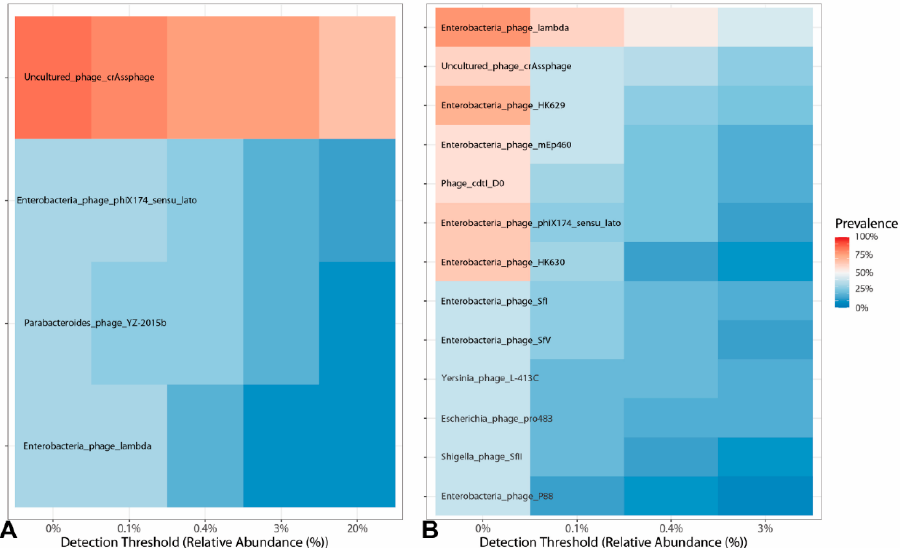
Figure 2. Heatmap of the core virome in pre- ( A ) and post-obesity ( B ) groups. Taxa prevalence is denoted red for higher values and blue for lower values.